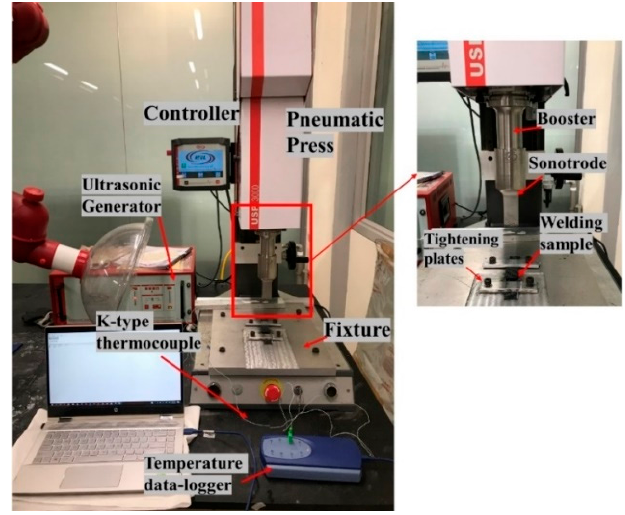
Figure 6. Details of the ultrasonic welding equipment used in the current project.